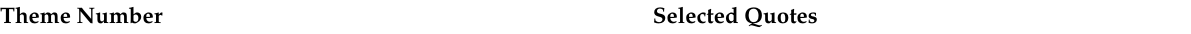
Table 5. Qualitative results—Selected